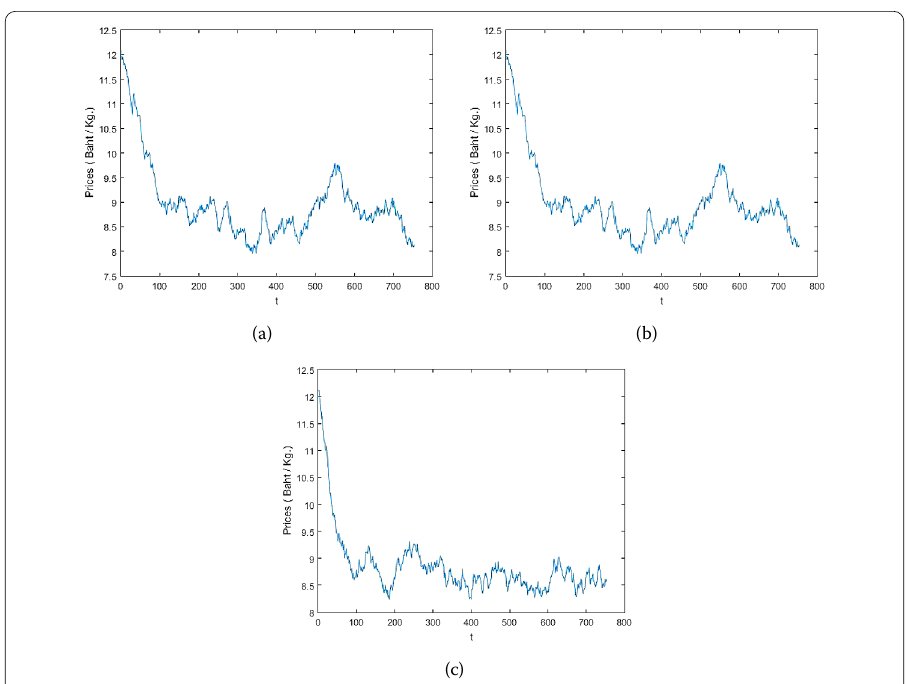
Figure 6 Results of simulation with Ornstein-Uhlenbeck process of TS: (a) Results of simulation with Ornstein-Uhlenbeck process of TS with least squares regression λ = 3.5025. (b) Results of simulation with Ornstein-Uhlenbeck process of TS with maximum likelihood estimation λ = 3.5025. (c) Results of simulation with Ornstein-Uhlenbeck process of TS with jackknife technique λ = 5.1518.